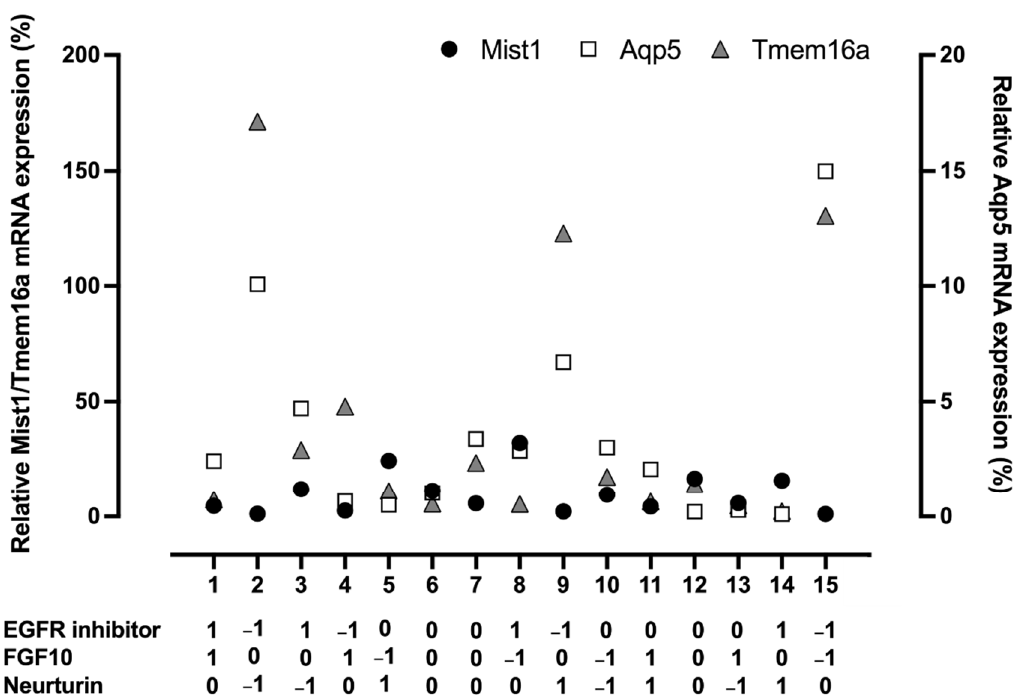
Figure 4. Individual runs from Box–Behnken show an impact on relative mRNA expression. Scatter plot of the results of the Box–Behnken runs for relative mRNA expression of Mist1 (black circles), Aqp5 (white squares), and Tmem16a (gray triangles). Each tick on the x-axis corresponds to the run number, with the levels ( − 1 and 1) of each factor shown underneath. mRNA expression is relative to the housekeeping gene Rps29 and day 0 tissue. Relative Mist1 and Tmem16a mRNA expression are plotted on the left y-axis and relative Aqp5 mRNA expression is plotted on the right y-axis.